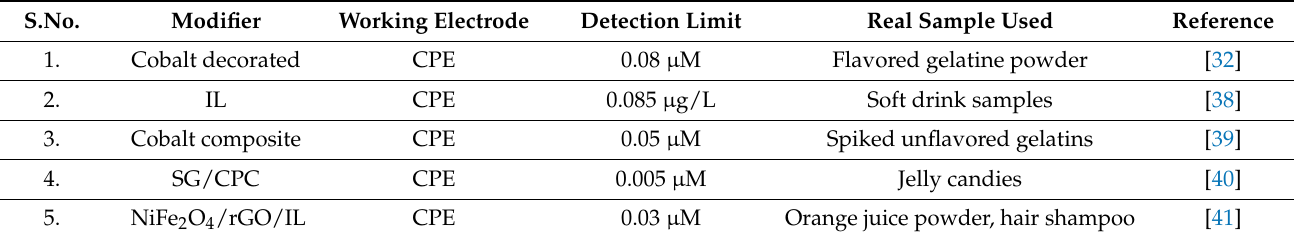
Table 6. Table showing Allura Red detection using carbon paste electrodes with different modifiers along with their detection